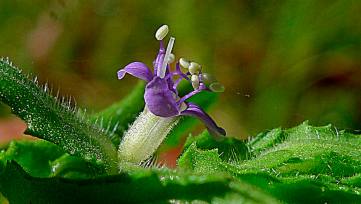
Figure 2. Stemodia maritima L. ( Scrophulariaceae ). (From: Alex Popovkin, Bahia, Brazil, available online: https: // flickr.com / photos / 12589168@N00 /